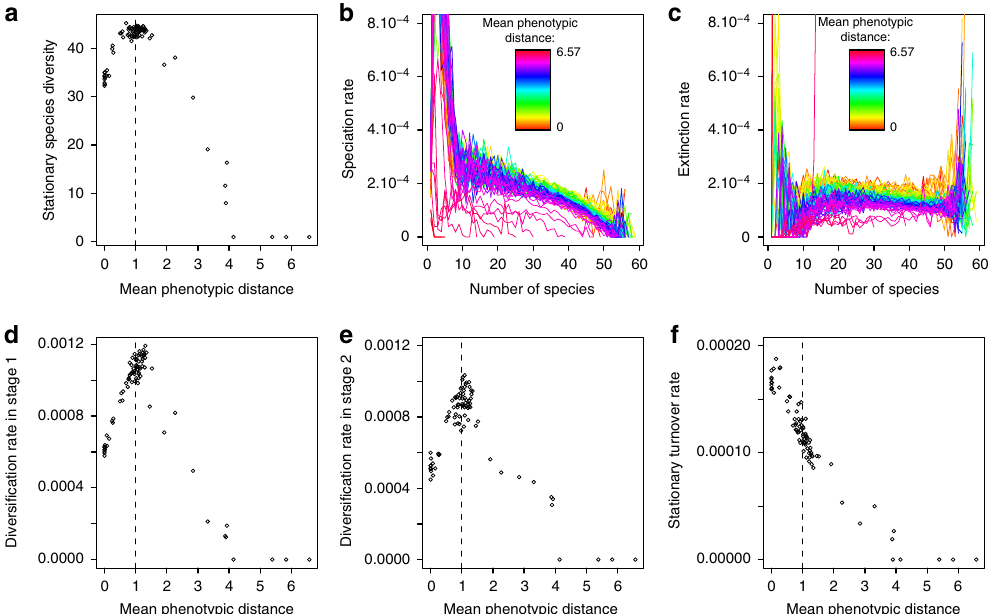
Fig. 5 Effect of sites distribution and distance between ecological optima on diversi fi cation dynamics. We generated 84 landscapes for which the environmental optima of the nine sites are randomly chosen in uniform distributions of various widths. The phenotypic distance between the optima of adjacent sites (and thus the degree of resource distributions overlap of adjacent sites) is different for each pair of sites, and there is no correlation between geographical proximity and ecological similarity (Supplementary Fig. 1). a Stationary species diversity as a function of the mean phenotypic distance between ecological optima of adjacent sites. b Speciation rate as a function of diversity. c Extinction rate as a function of diversity. d – f Diversi fi cation rate in stage 1 ( d ), in stage 2 ( e ), and stationary turnover rate ( f ) as a function of mean phenotypic distance between environmental optima of adjacent sites. The vertical dashed line indicates the phenotypic distance between environmental optima of adjacent sites in the baseline version of the model. The results are based on 50 simulation replicates for each landscape. Parameter values as in Supplementary Table